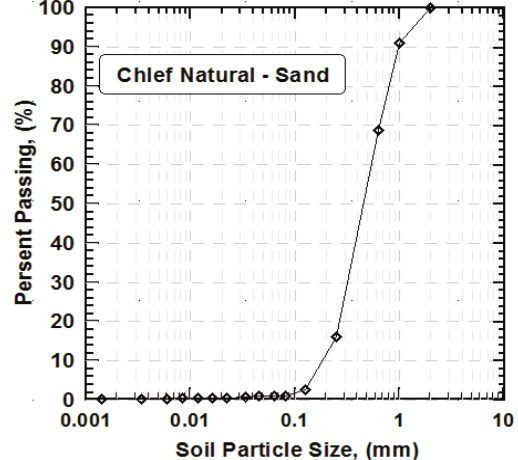
Fig. 2. Particle size distribution curve of test